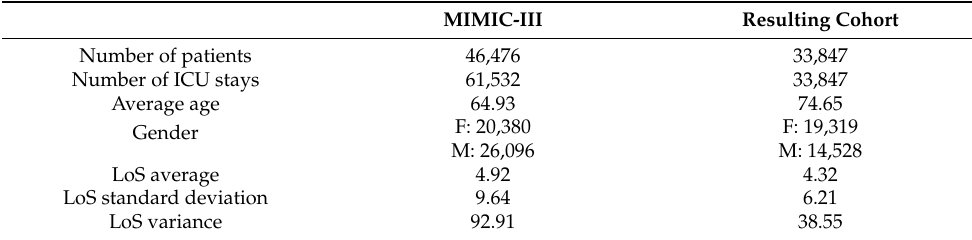
Table 3. Characteristics of the data source.